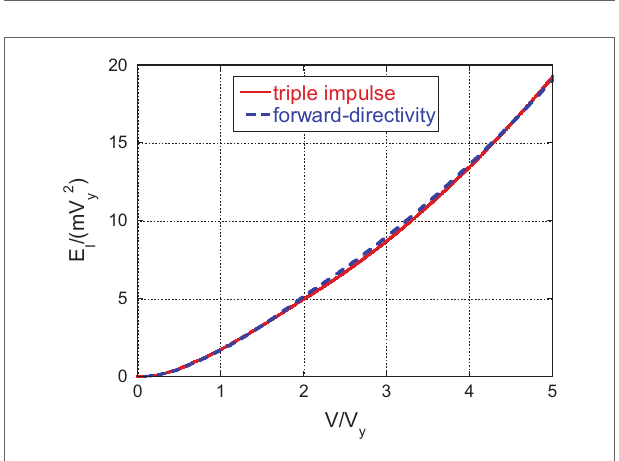
FigUre 10 | comparison of ductility of elastic–plastic structure under triple impulse and the corresponding three wavelets of sinusoidal waves .